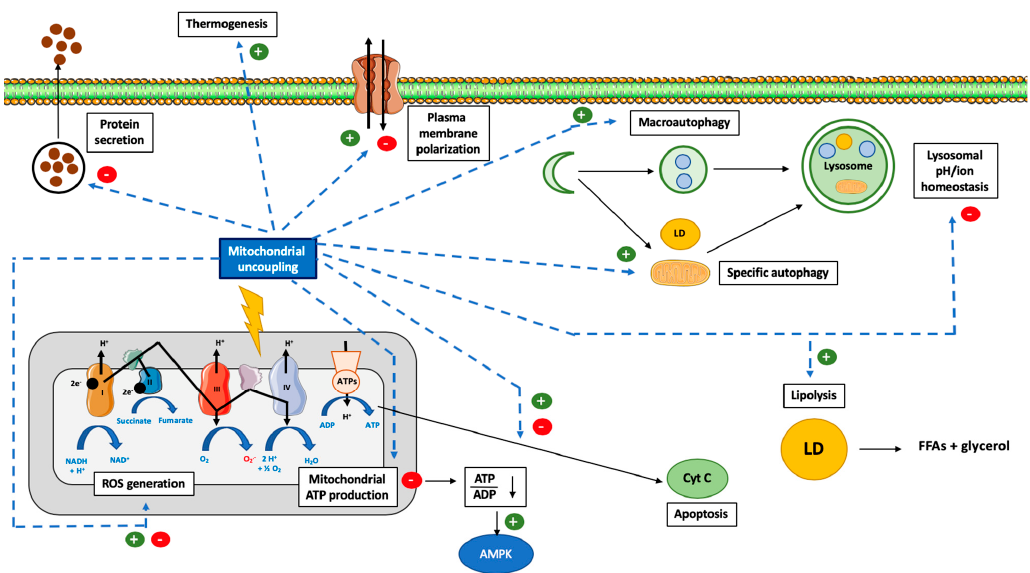
Figure 1. Overview of the cellular consequences of mitochondrial uncoupling. Abbreviations: ADP (Adenosine DiPhosphate), AMPK (Adenosine Monophosphate-Activated Protein Kinase), ATP (Adenosine Triphosphate), ATPs (ATPsynthase), CytC (Cytochrome C), FFA (Free Fatty Acid), LD (Lipid Droplet), ROS (Reactive Oxygen Species), NAD (Nicotinamide Adenine Dinucleotide). Induction of mitochondrial uncoupling by use of synthetic or natural uncoupling agents or by activating dedicated proteins, such as UCPs or ANTs, can trigger several cellular mechanisms. The first e ff ect, and the most well-known, is the inhibition of mitochondrial ATP production by ATP synthase due to the dissipation of the mitochondrial proton gradient. This energy will be dissipated as heat (thermogenesis). The decrease in cytosolic ATP will be sensed by AMPK and lead to its activation. In addition, the decrease in mitochondrial potential membrane will also modify ROS generation. In order to cope with this energy loss, autophagy will also be triggered (both bulk and specific forms of autophagy). Lipid droplets (LD) will be degraded by a form of autophagy and help to fuel the cell with lipids. Loss of the mitochondrial potential membrane will also allow the identification of these dysfunctional mitochondria by autophagy (mitophagy). Mitochondrial uncoupling can also help to protect cells against cell death and apoptosis but can also promote it, according to the cell type, mitochondrial uncoupler and mitochondrial uncoupling intensity considered. Finally, the use of non-specific mitochondrial uncouplers, such as FCCP or DNP, could alter the homeostasis of several ions, such as Ca 2 + , Na + and K + (at the cytosolic, mitochondria, or lysosomal levels), which will lead to a decrease in protein secretion and plasma membrane (de)polarization,